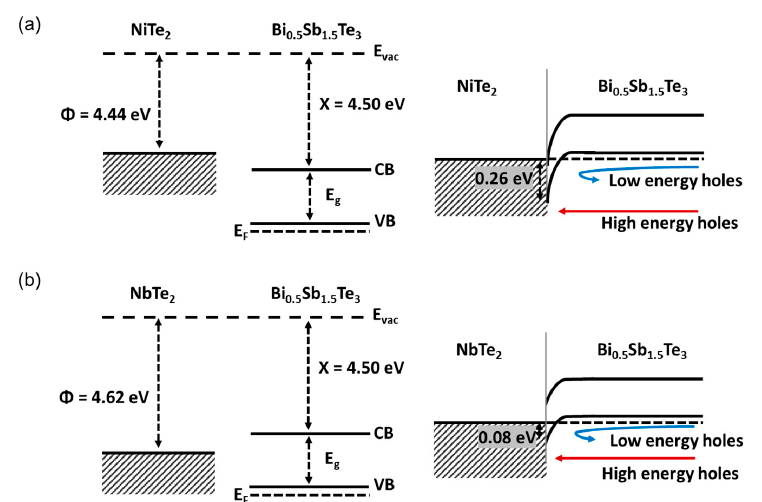
Figure 2. Schematic of energy band diagrams of the samples at the heterointerfaces between Bi 0.5 Sb 1.5 Te 3 and the secondary phase: ( a ) NiTe 2 and ( b ) NbTe 2